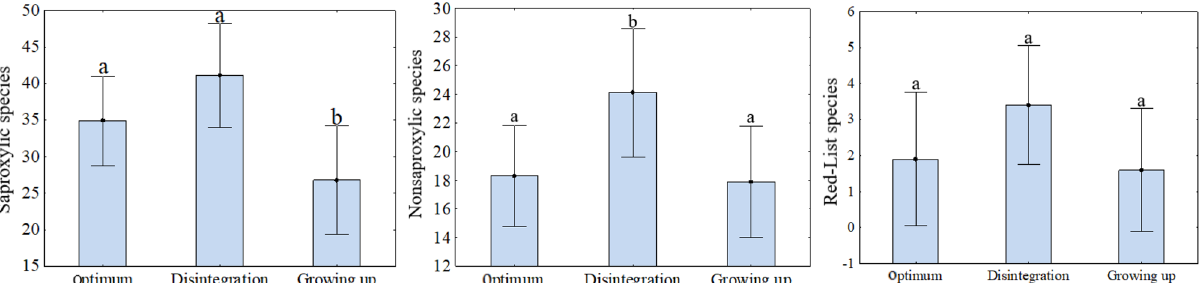
Figure 7. Mean number of beetle species by stage over the study period. According to beetle group (1) saproxylic species (2) non-saproxylic species (3) red-listed species. Vertical error bars denote standard deviation (SD), end of chart mean (mean ± SD) Letters above error bars indicated differences by Tukey HSD Post Hoc test.